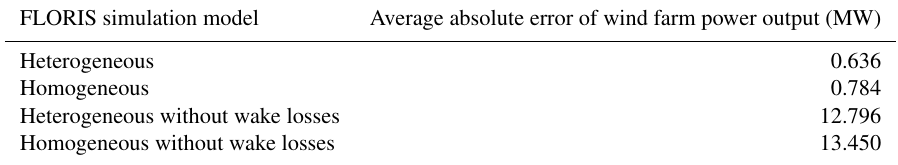
Table B1. Absolute error of total wind farm power output predictions for four different FLORIS models compared to LES simulations, as discussed in Sect. 4.1. An average absolute error is reported, which was taken over all wind direction cases.